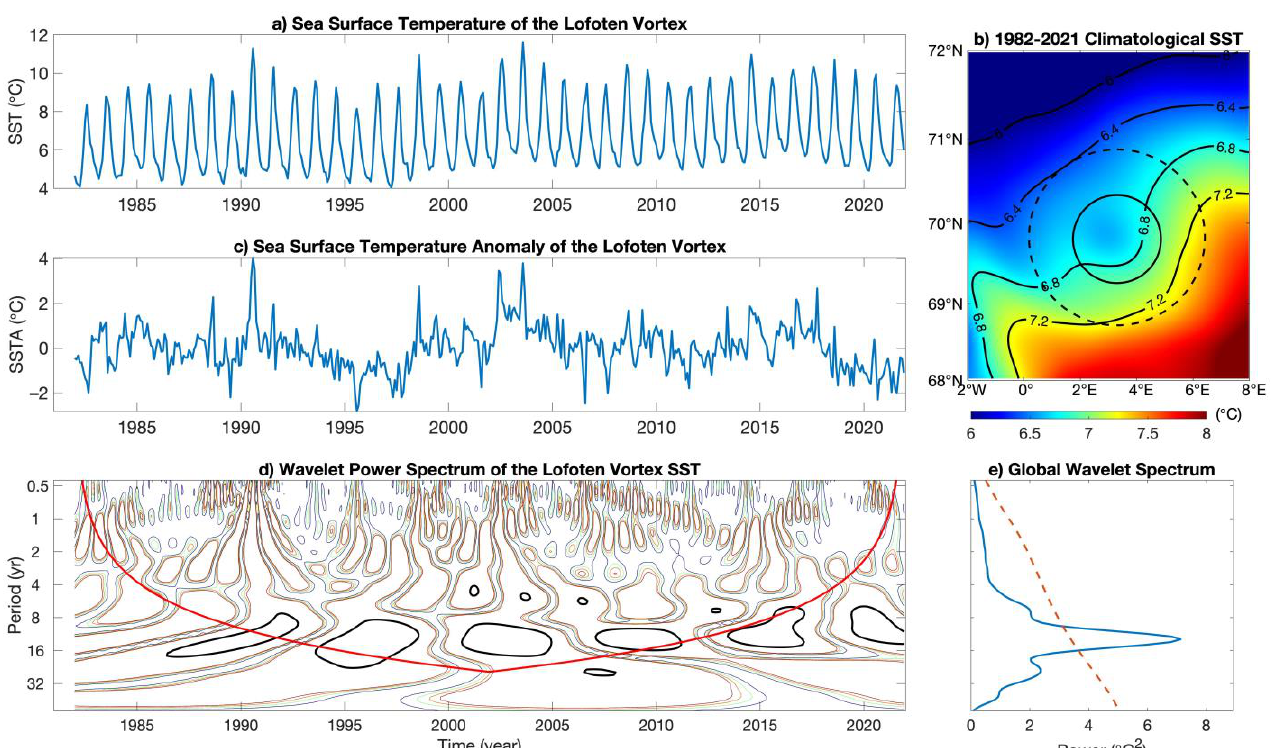
Figure 8. Wavelet analysis of the time series of the spatially averaged SST throughout the CCLV sea area. ( a ) Original SST time series. ( b ) Spatial field of the climatological SST from 1982 to 2021. ( c ) Residual SST time series (with trend and annual cycle removed). ( d ) Wavelet power spectrum of the residual SST time series. Statistical significance ( p = 0.05, Student’s t test) is shown by thick red isolines. ( e ) Global wavelet spectrum and the red noise line.